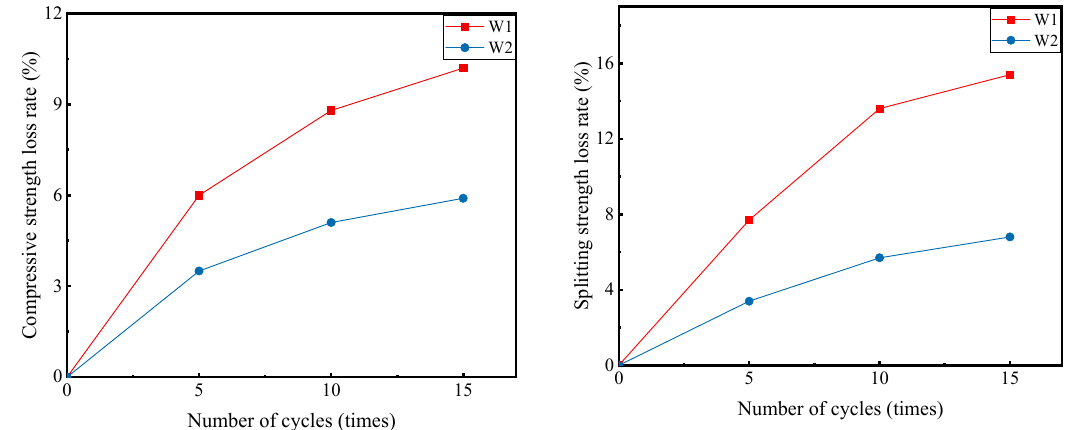
Figure 8. Relationship between the number of cycles and the rate of loss of mechanical strength of cement-stabilized macadam.